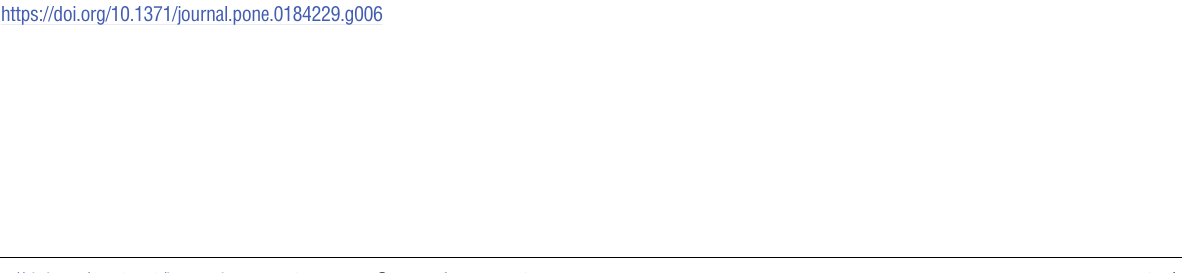
PLOS ONE | https://doi.org/10.1371/journal.pone.0184229 September 6, 2017 15 /